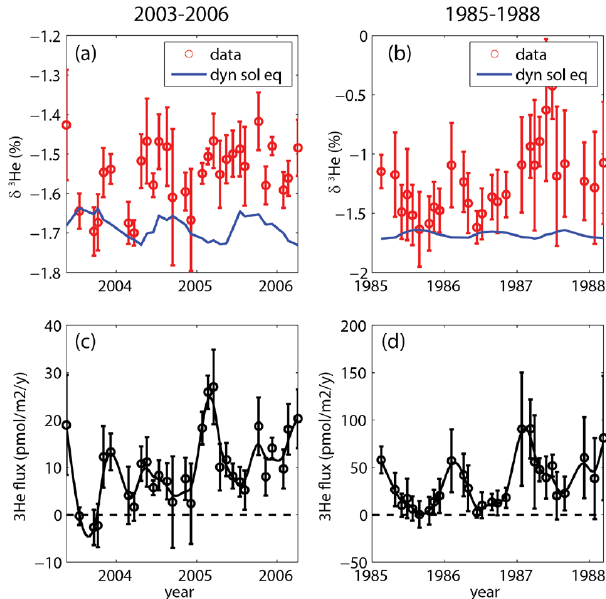
Figure 2. Mixed-layer δ 3 He data from (a) 2003 to 2006 and (b) 1985 to 1988 as well as the dynamic solubility equilibrium for δ 3 He. Error bars represent standard error of multiple measurements within the mixed layer. Fluxes of 3 He calculated from the data for (c) 2003–2006 and (d) 1985–1988. Note the difference in scales on the y axes for the two time